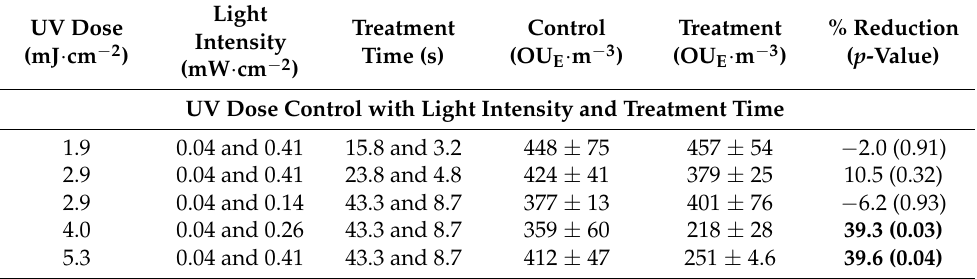
Table 1. Mitigation of odor with UV-A photocatalysis treatment. Control temperature = 28.5 ± 2.3 ◦